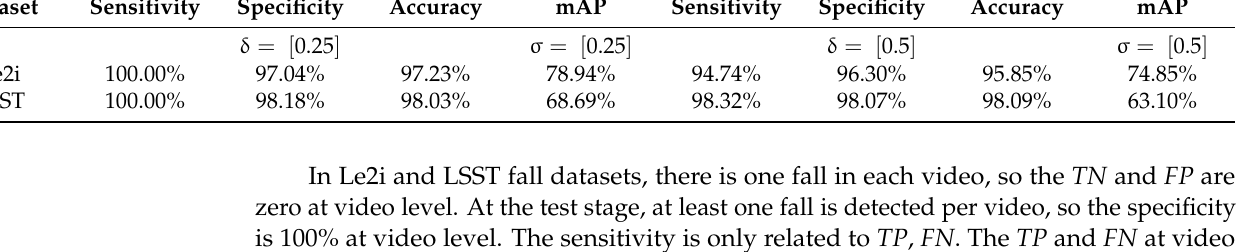
Table 5. The performance of the proposed algorithm on Lei2 and LSST dataset at slot level.